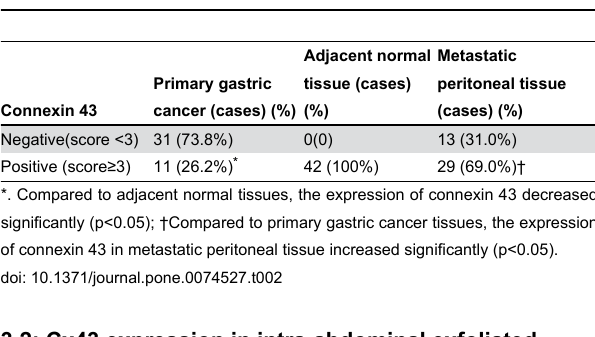
Table 2. Immunohistochemistry results for Connexin 43 expression in primary gastric cancer tissues, adjacent normal gastric tissues and peritoneal metastatic tissues